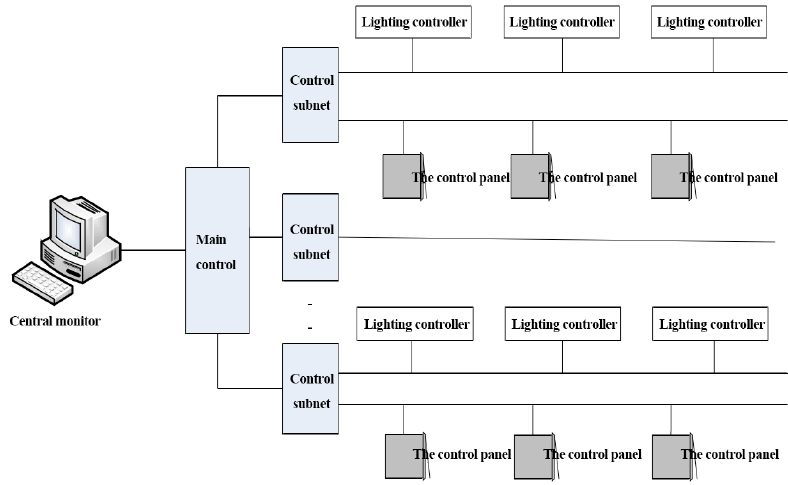
Figure 2. The structure of the distributed lighting control